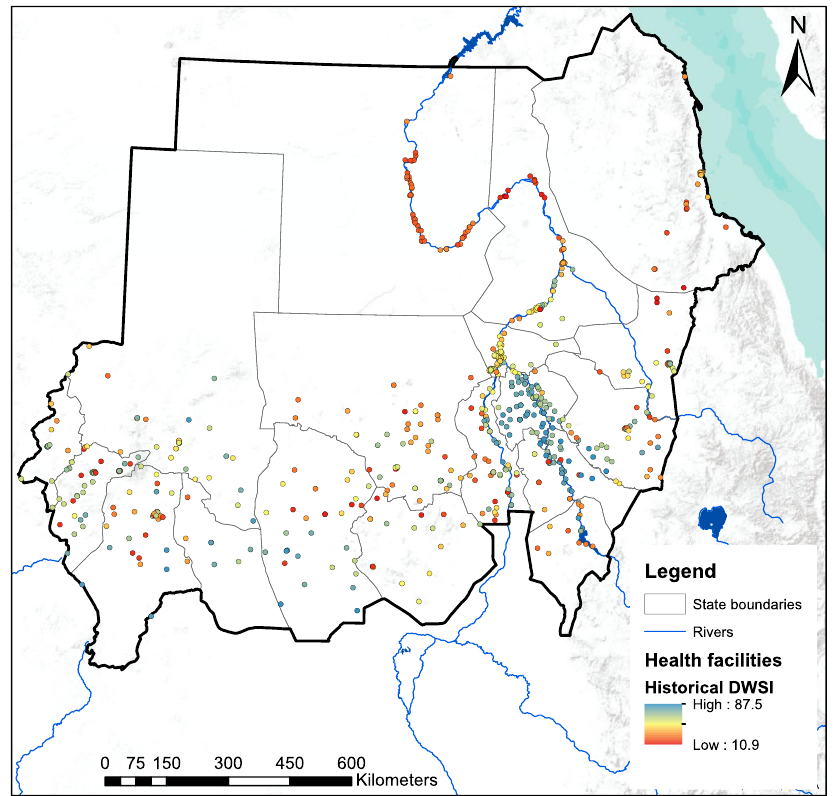
Figure 5. Historical DWSI at health facility level.